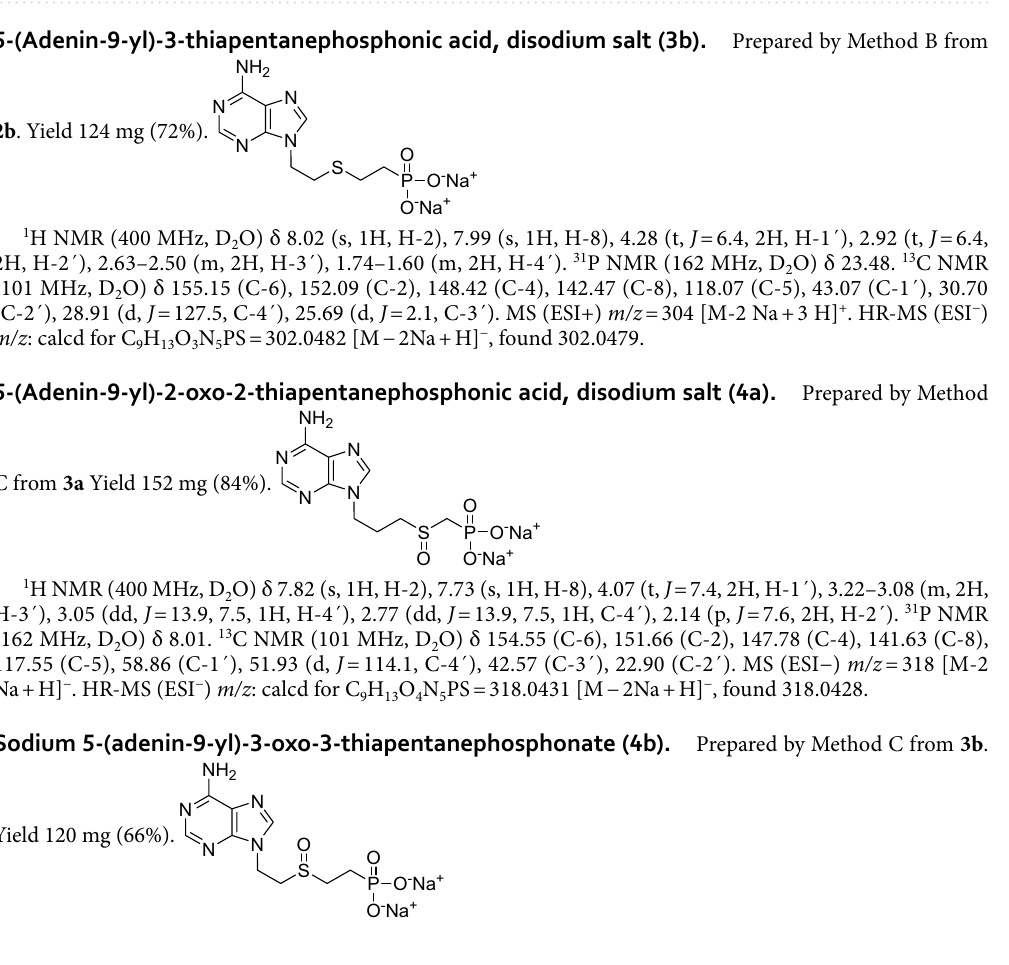
Figure 8. Flow cytometry analysis of DNA content of T. brucei cells treated with selected ANPs 24a , 24b , 28 and 27 at the concentration ranging from 1 to 16 µM depending on the tested inhibitor. Histograms show the distribution of DNA content of trypanosomes after exposure to selected ANPs. ( A ) Fluorescence intensity in the PE-A channel is shown on the x axis and number of cells on the y axis (example for 24b ); ( B ) Bar chart displaying the percentage of cell at G0/G1, S and G2 phase. (means ± S.D., n = 3–7, Student’s unpaired test, ***p < 0.001, **p < 0.01, *p <